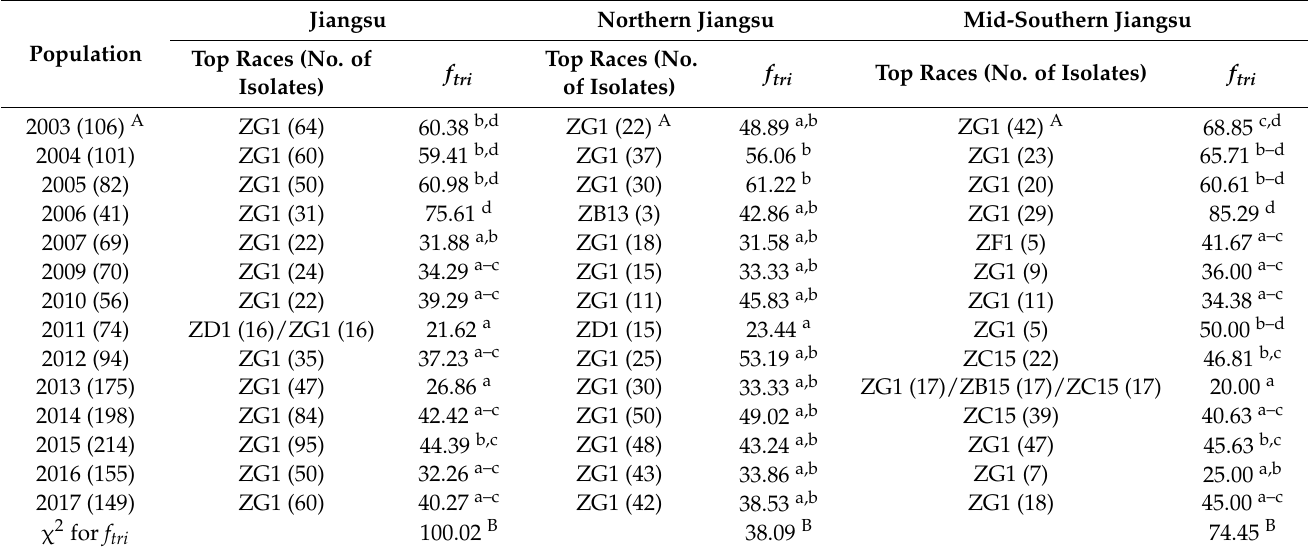
A: Numbers shown in parentheses indicate the number of isolates tested. B: Significant at the p = 0.01 level for a χ 2 . The same superscript lowercase letters represent no significant difference at the p = 0.05 level. f tri : The top race isolate frequency and the equation are shown in Table